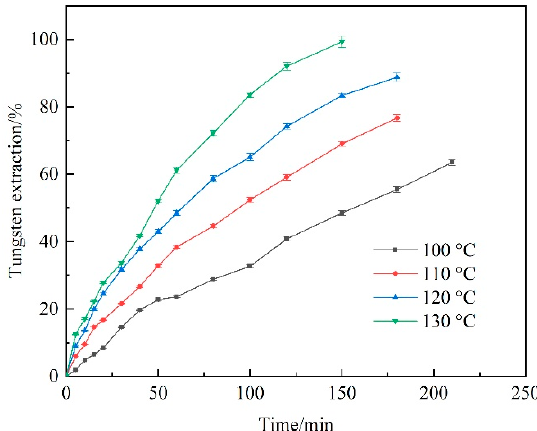
Figure 2. Effect of temperature on the leaching efficiency of tungsten.